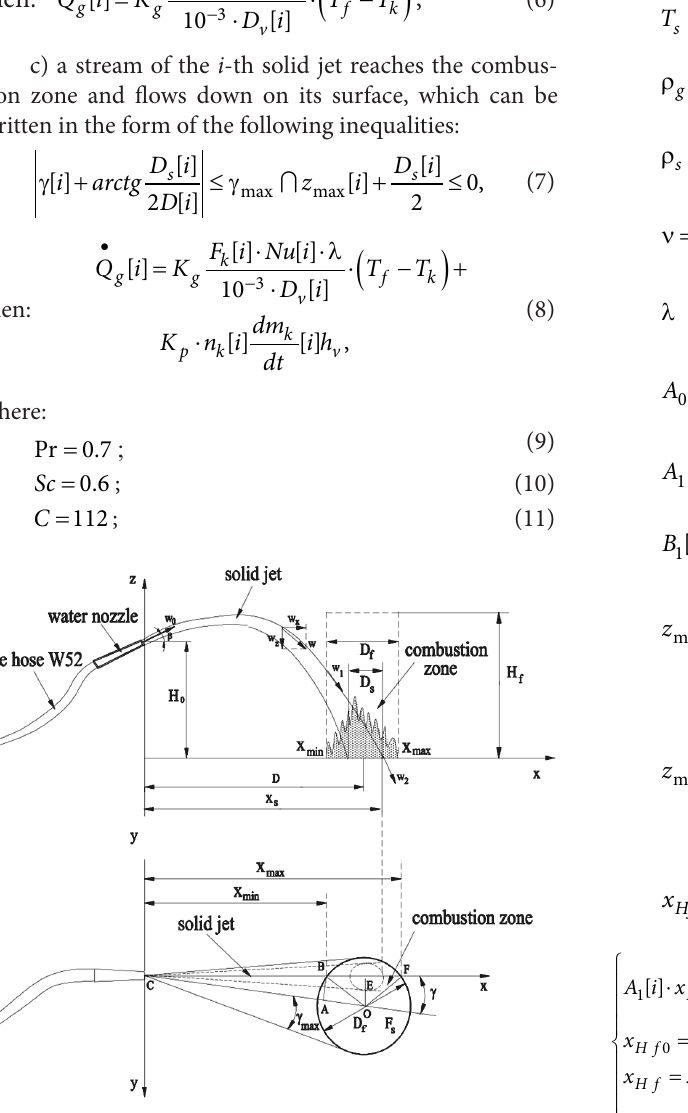
Figure 1. Drops trajectory during the extinguishing process using solid jet (vertical top view, horizontal